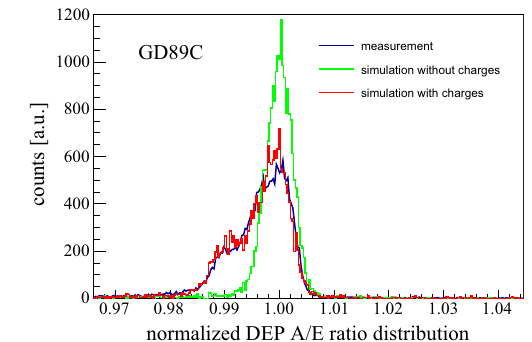
0.97 0.98 normalized DEP A/E ratio distribution Fig. 14 Detector GD89C: measurement vs. siggen -based simula- tion of the A / E ratio distribution of DEP events. In both cases, the 228 Th source placed in 20cm distance from the detector was not colli- mated